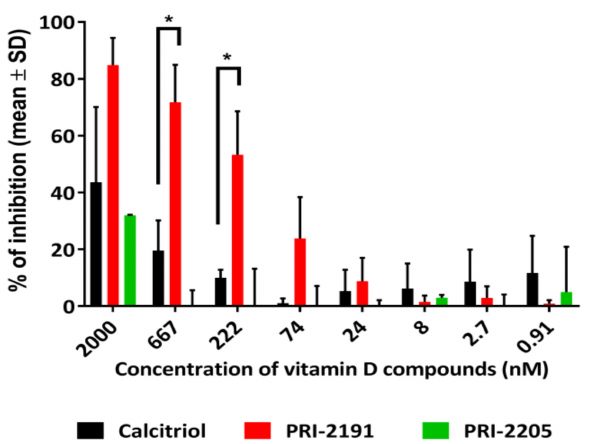
Figure 3. Aromatase inhibition by calcitriol and vitamin D compounds PRI-2191 and PRI-2205 (Corning CYP19 inhibition test). The concentrations of the compounds were used according to the manufacturers’ protocol by referring to the concentrations of the positive control used (ketoconazole). Ethanol was used as a solvent for the compounds. The test was performed three times, each time in triplicates. Statistical analysis was performed using the nonparametric Kruskal-Wallis test. p < 0.05 was considered to be statistically significant; * compared to calcitriol.